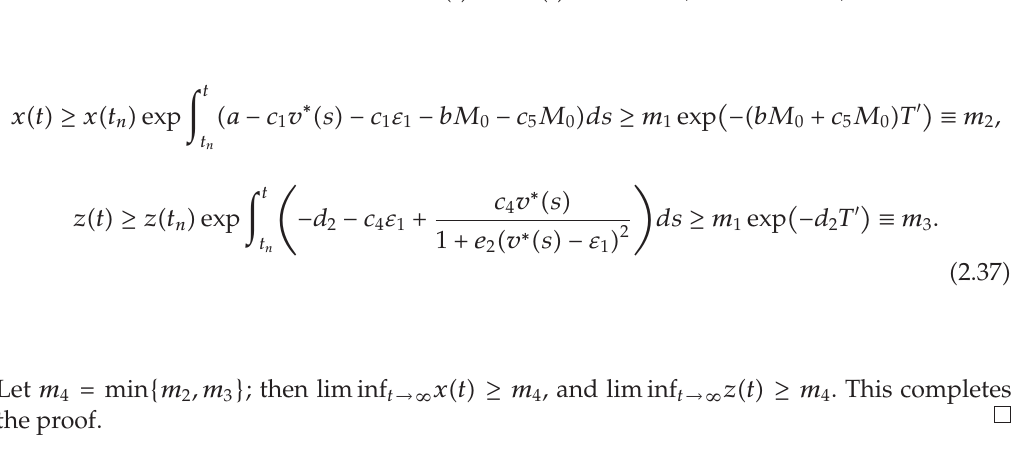
} such that t − t → ∞ as n → ∞ . From Step 1, this can lead to a n i (cid:8) 1 n i i i